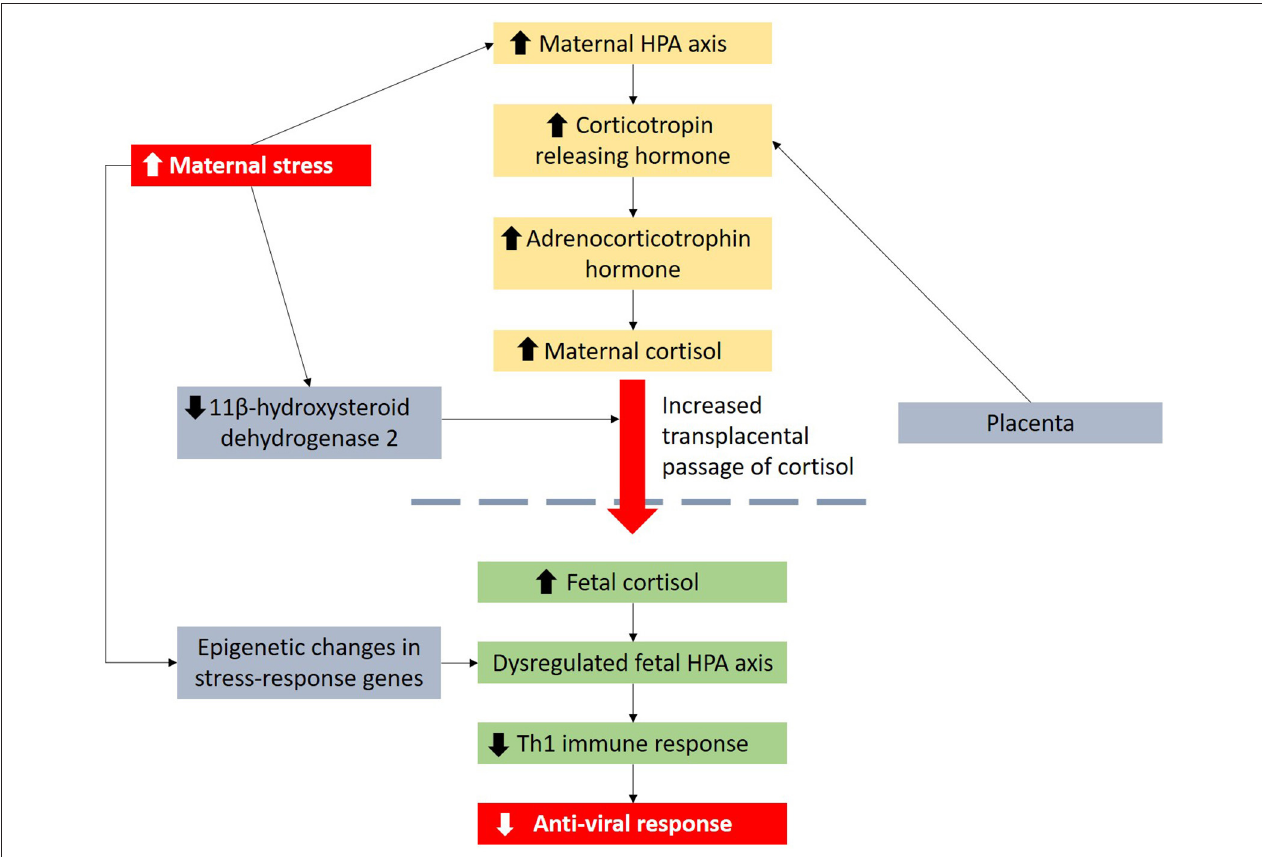
FIGURE 1 | Maternal distress is linked to viral infection in children through dysregulation of the HPA axis and influence of Th1 immune response. Maternal distress can also lead to epigenetic changes in stress-response genes.